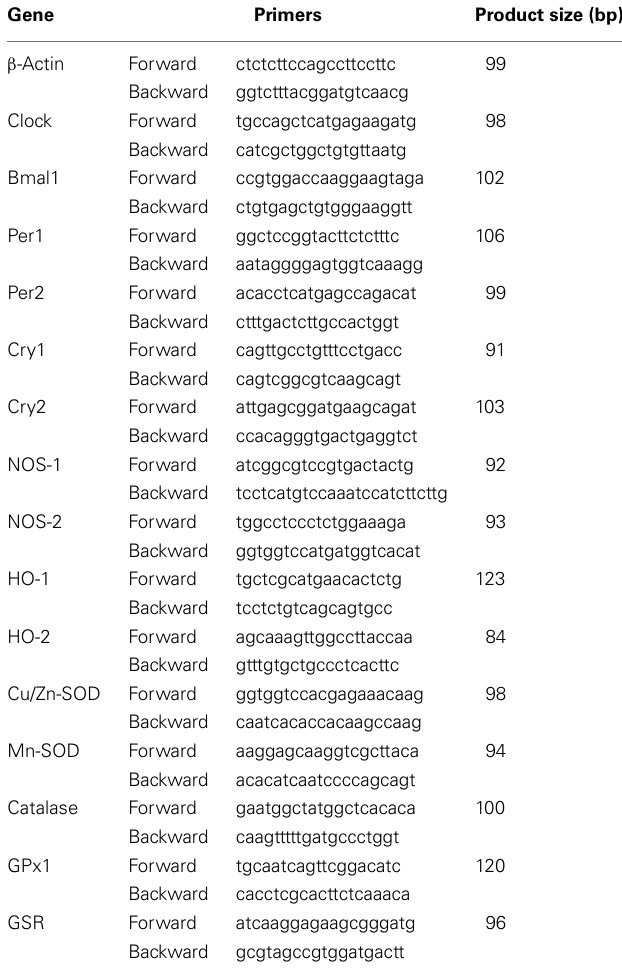
Table 1 | Sequence of the primers used for real-time